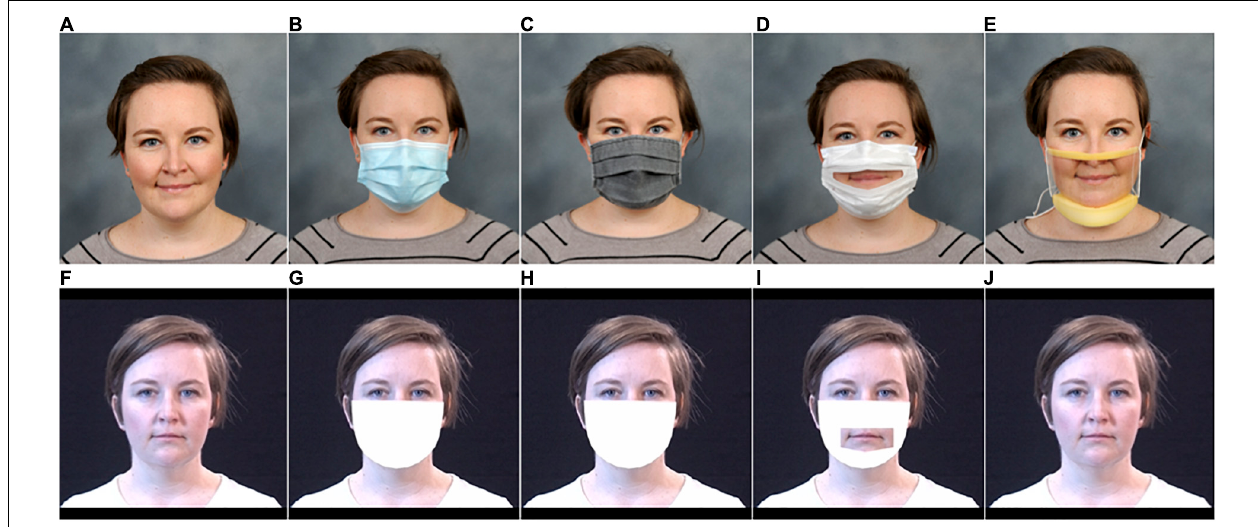
FIGURE 1 | Illustration of the five mask conditions. The top row contains photographs of the five conditions: (A) no mask, (B) hospital mask, (C) fabric mask, (D) Communicator TM , and (E) ClearMask TM . The bottom row shows the associated visual face mask simulations: (F) no mask, (G) hospital mask, (H) fabric mask, (I) Communicator TM , and (J) ClearMask TM